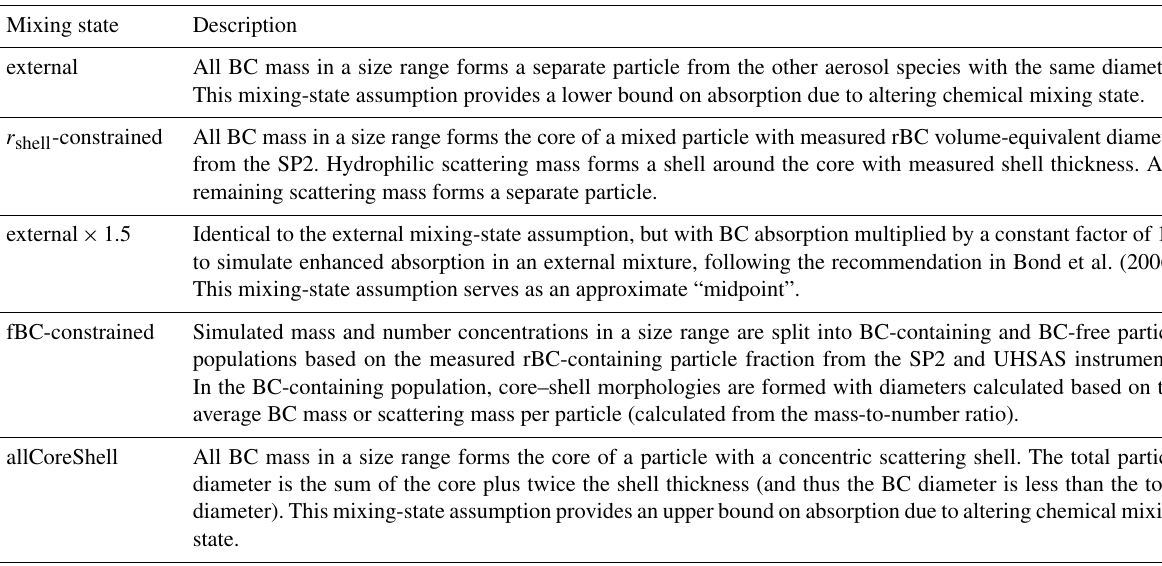
Table 1. Description of BC mixing